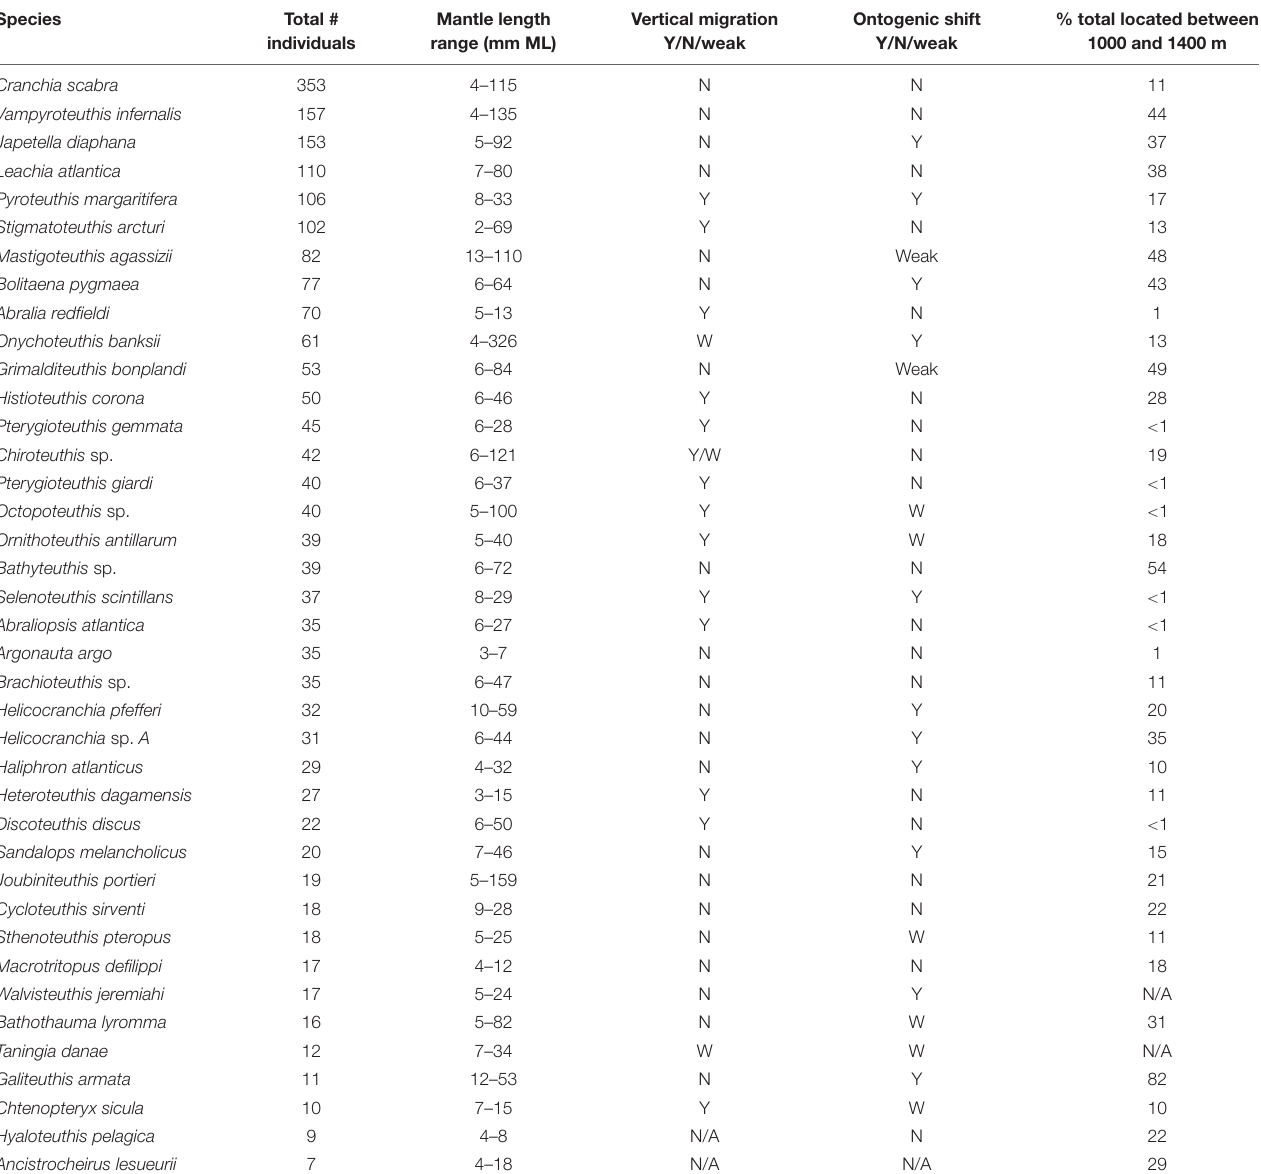
TABLE 1 | Midwater cephalopods ordered by abundance; total individuals examined; mantle length range; evidence of vertical migration; evidence of ontogenic shift; percent of species that was found between 1000 and 1400 m. Species Total # Mantle length Vertical migration Ontogenic shift % total located between individuals range (mm ML) Y/N/weak